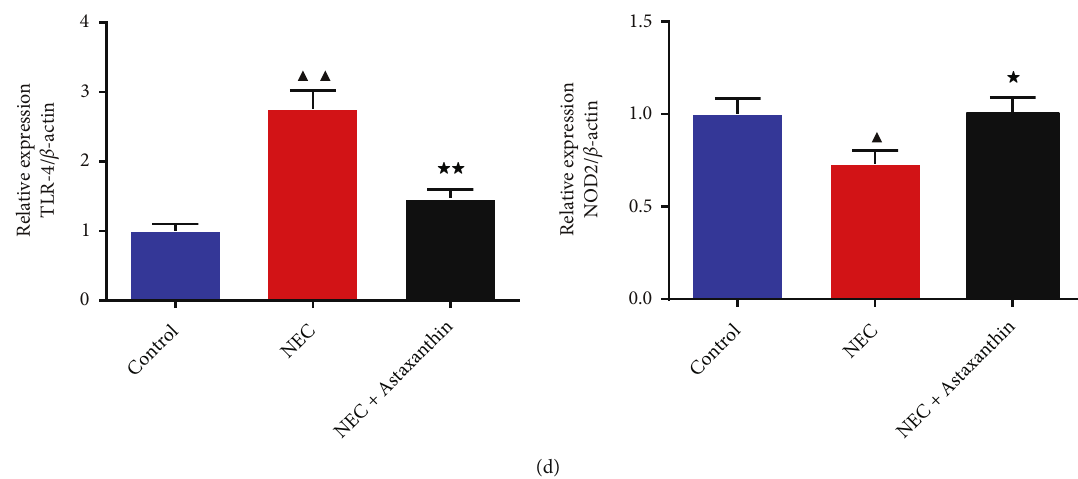
Figure 4: Astaxanthin inhibited the in fl ammatory- and apoptosis-related proteins of intestinal tissues in NEC rats. (a, b, c, and d) Western blot was used to test the expressions of TNF- α , inducible nitric oxide synthase (iNOS), nuclear factor- κ B (NF- κ B), BAX, Bcl-2, toll-like receptor 4 (TLR4), and nucleotide-binding oligomerization domain 2 (NOD2) of intestinal tissues in rats, n = 3 in each group; ▲ P < 0 : 05 , ▲▲ P < 0 : 01 vs. control group. ★ P < 0 : 05 , ★★ P < 0 : 01 vs. NEC